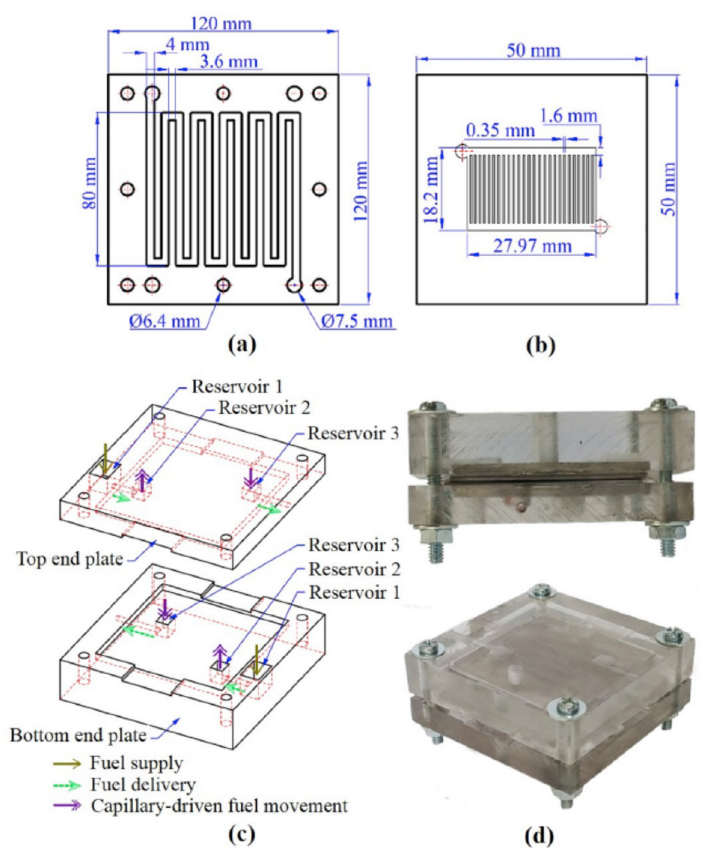
Figure 7. The design of flow channel plates for ( a ) typical EBFC (with pump) and ( b ) self-pumping EBFC (without pump); ( c ) schematic diagram of top and bottom end plates in the self-pumping EBFC stack and ( d ) photograph of self-pumping EBFC assembly [17]. Copyright 2019